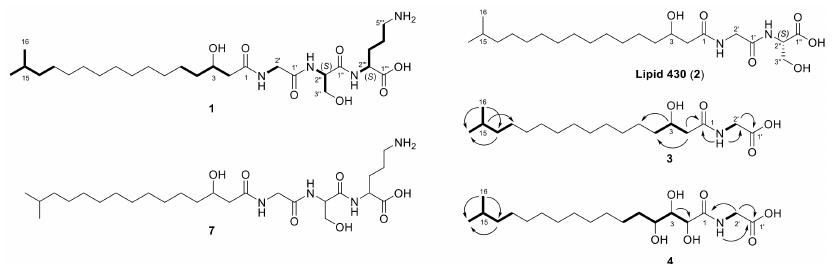
Figure 2. Chemical structures of lipoamino acids 1 – 4 and 7 produced by C. eiseniae DSM 22224 ( 1 , 7 ) and Olivibacter sp. FHG000416 ( 2 – 4 ). The COSY (in bold) and key H → C HMBC (arrows) correlations observed for lipids 1 , 3 , and 4 are indicated.